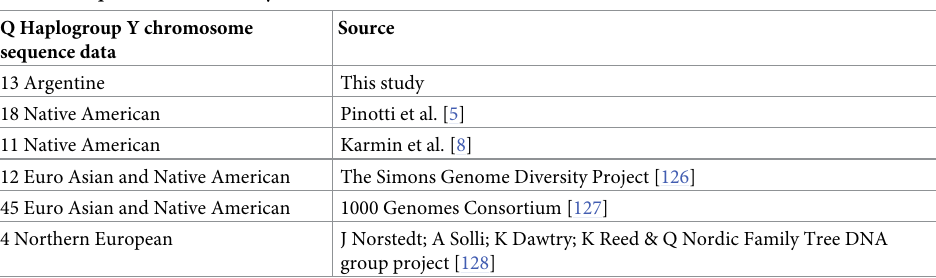
Table 2. Sequence data summary